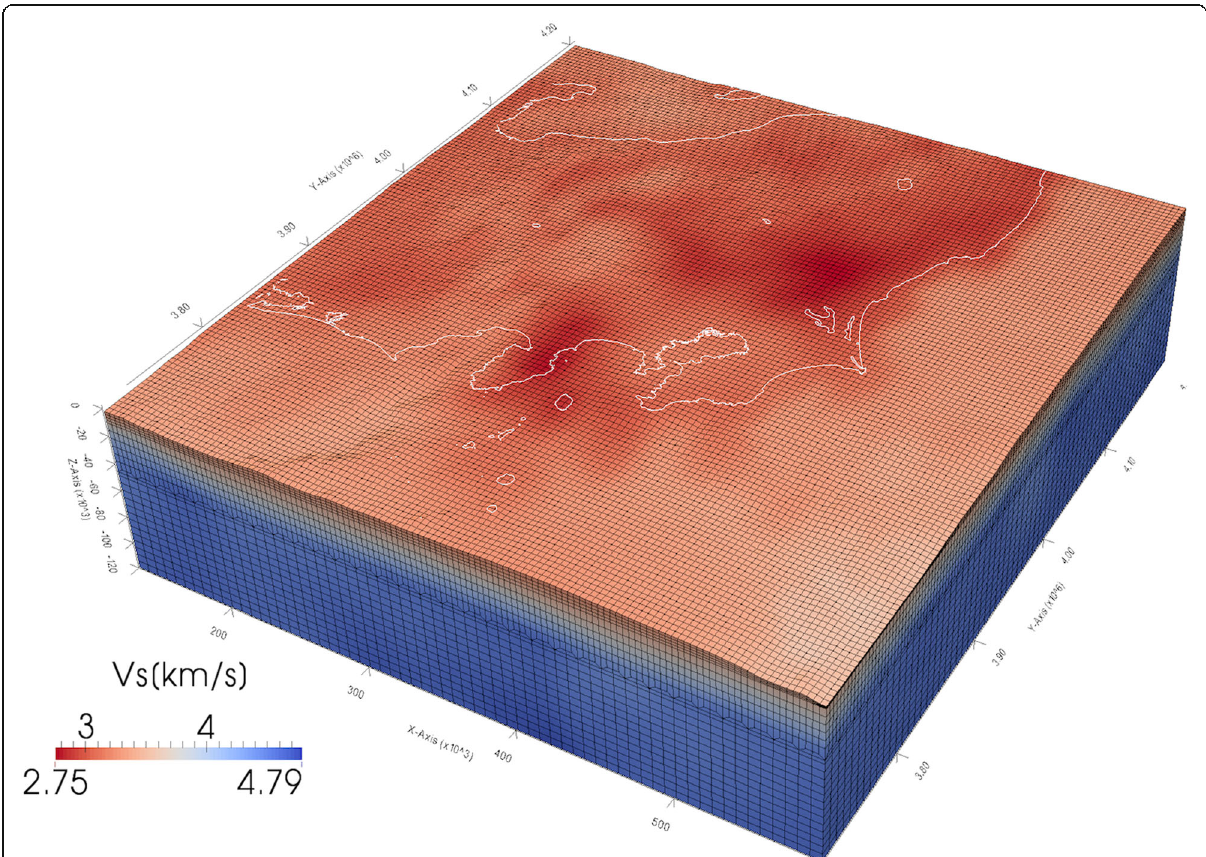
Fig. 3 Mesh and shear wave speed structures of the initial model. The color indicates the S-wave speed V